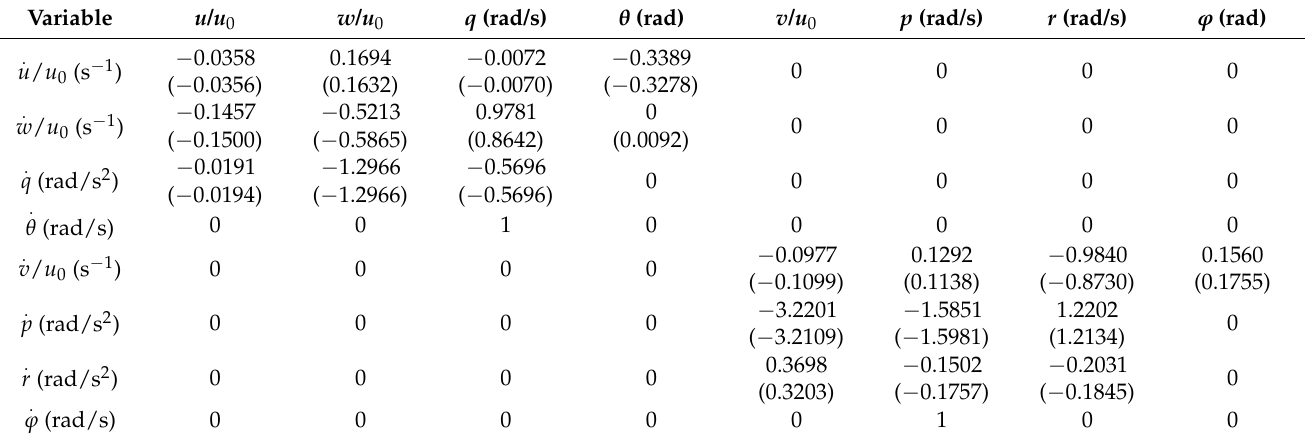
Table 15. CFD–RANS (extrapolated) 8 × 8 stability matrix for flight condition 8 in Tables 4 and 5.